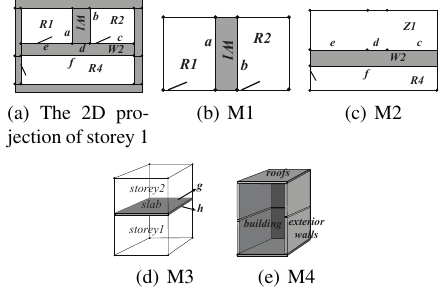
Figure 4. The 3-cells and combinatorial maps of Figure 3 New assignments of 4 colors of nodes and 5 kinds of labels of edges are defined as follows. Black Node: A black node is an n-map node whose n-map is a connected combinatorial map. The associated n-map of a black node can be a connected local part of a connected n-map. White Node: A white node is a region node which is associated with a spatial structure (e.g., the instances of IfcSpatialStruc- tureElement ). The associated spatial structure does not directly cover any other spatial structures or building elements. A white node is a leaf node or a root